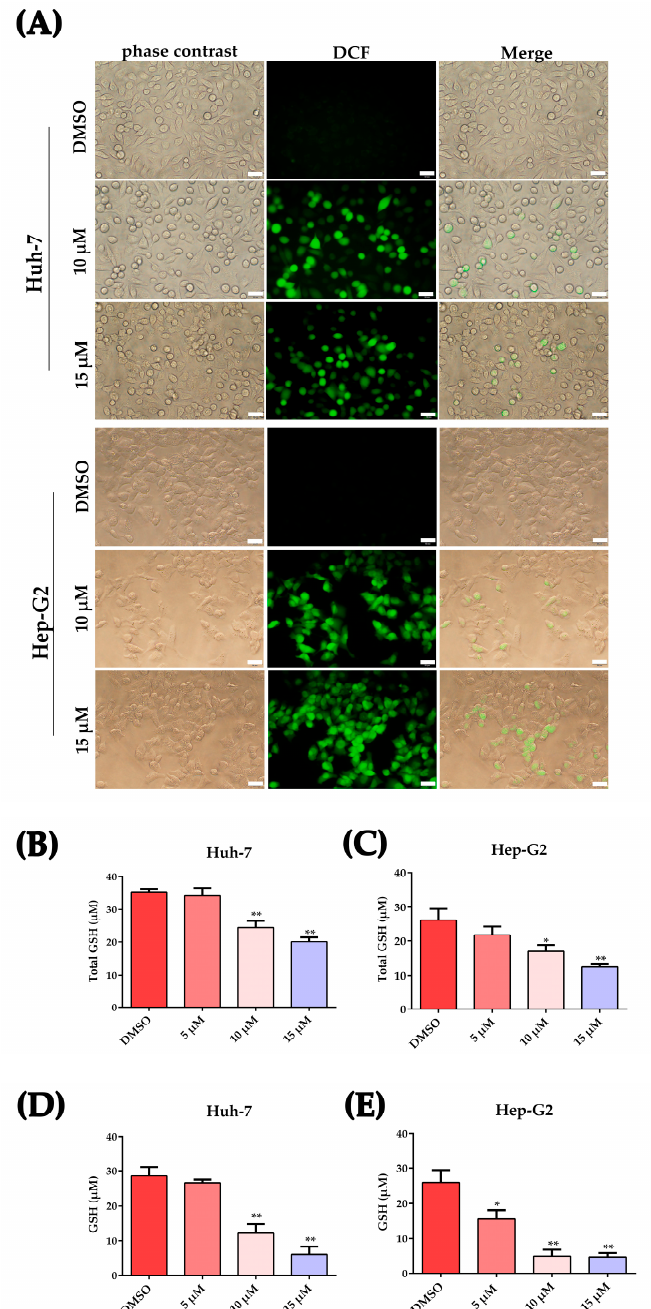
Figure 3. Plumbagin-induced oxidative stress in HCC cells. ( A ) Detection of ROS in HCC cells after plumbagin treatment. Nonblooming DCFH probes were oxidated by intracellular ROS and yielded a highly fluorescent product—DCF, which could be detected by fluorescent microscopy. ROS increased in Huh-7 or Hep-G2 cells after 12 h treatment with 10 µ M and 15 µ M plumbagin. Scale bar = 20 µ m. ( B , C ) The total GSH level in HCC cells under PLB treatment. HCC cells were treated by different concentrations of PLB; then, the total GSH level was measured with the GSH and GSSG Assay kit (Beyotime, Shanghai, China). The data are expressed as the mean ± SD of three independent samples. * p < 0.05; ** p < 0.01 compared to the DMSO group. ( D , E ) The alterations in GSH relative content in cells after PLB treatment. After PLB treatment for 12 h, the cells were lysed and the GSSG level was tested using the kit mentioned above. GSH levels were further calculated following the instructions. The data are expressed as the mean ± SD of three independent samples. * p < 0.05, ** p < 0.01 compared to the DMSO